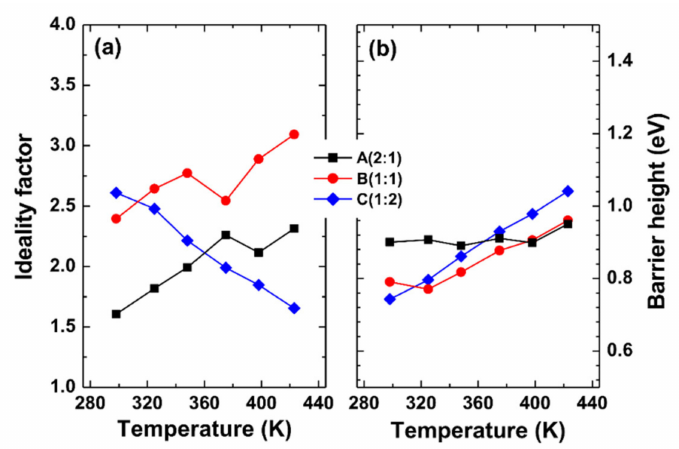
Figure 3. ( a ) Barrier height and ( b ) ideality factor at di ff erent